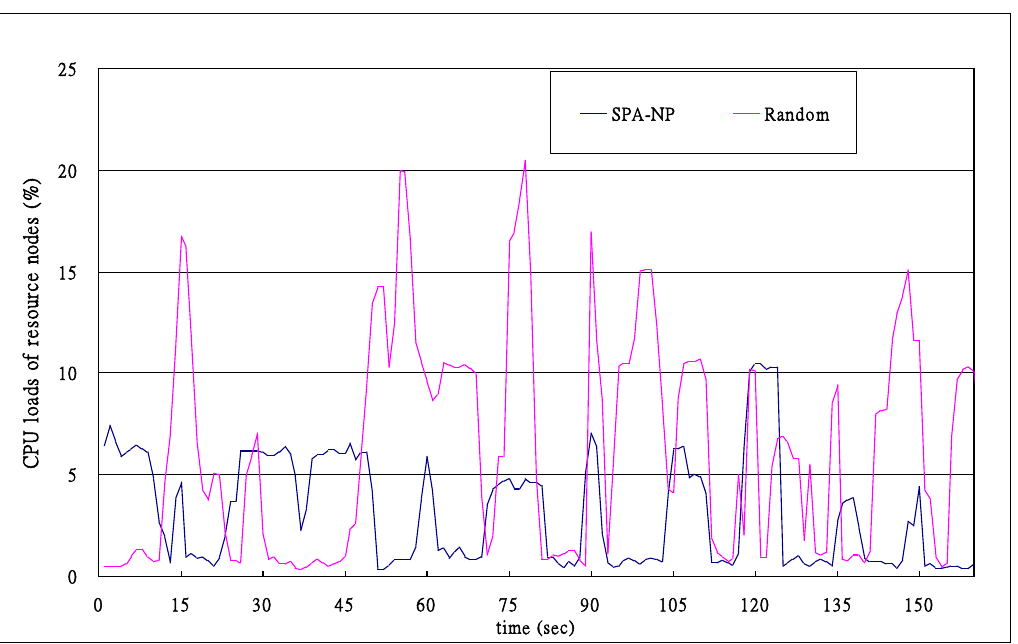
Figure 10. CPU loads of the SPA-NP and Random algorithms (150th–1500th s are not shown since they are similar to the shown